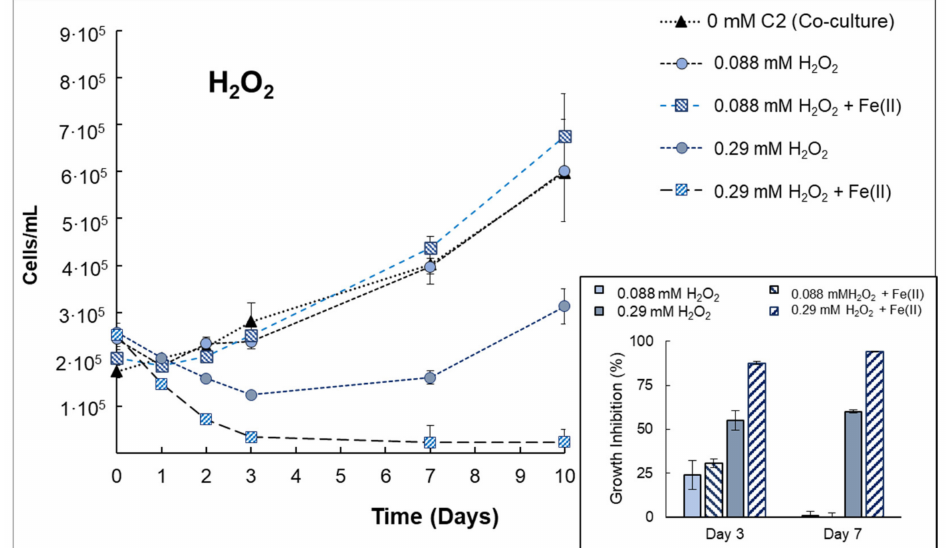
Figure 5. Growth curves of Anabaena sp. in co-culture with V. alginolyticus for single H 2 O 2 or H 2 O 2 + Fe(II) treatments. Inset: Specific growth inhibition (%) obtained at day 3 or 7 for Anabaena sp. exposed to H 2 O 2 or H 2 O 2 + Fe(II)